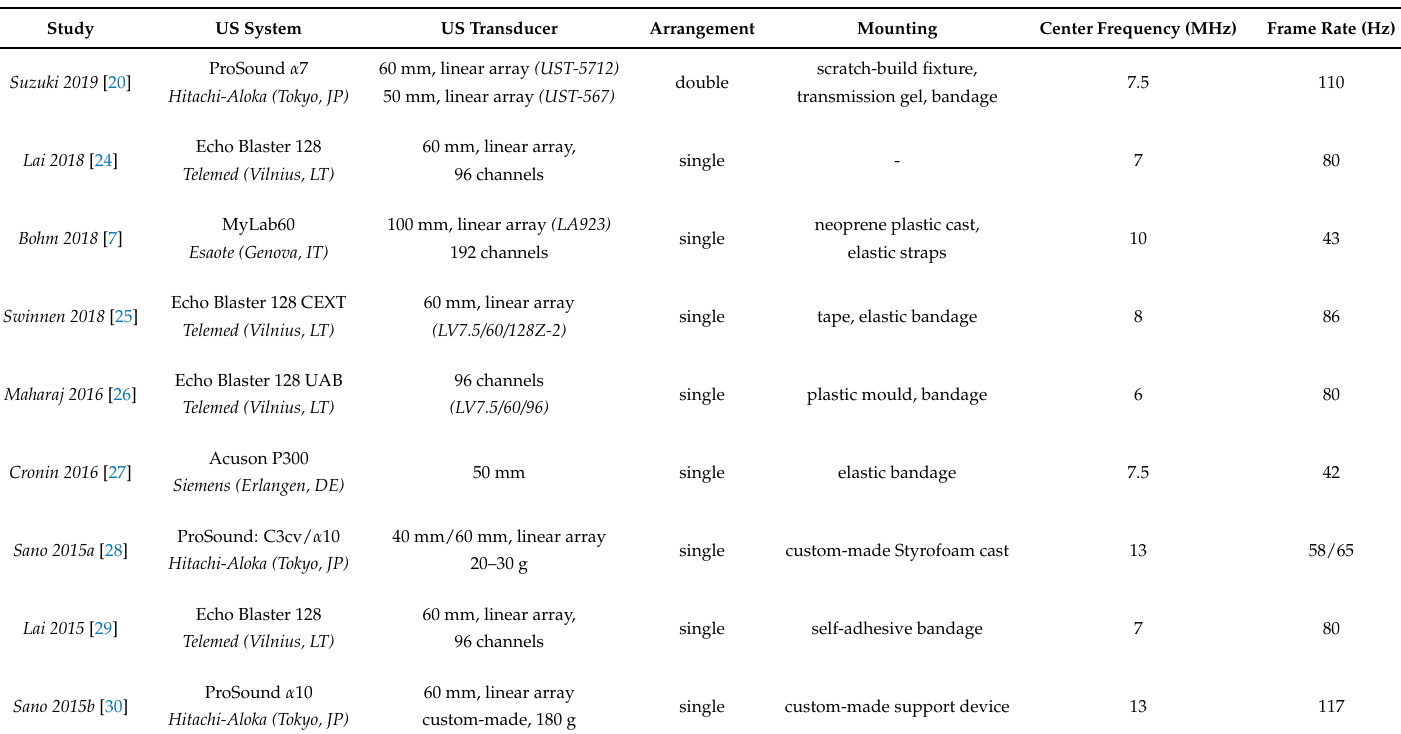
Table 1. US sensor system and transducer specifications as well as operating parameters in the biomonitoring of muscle and tendon dynamics during